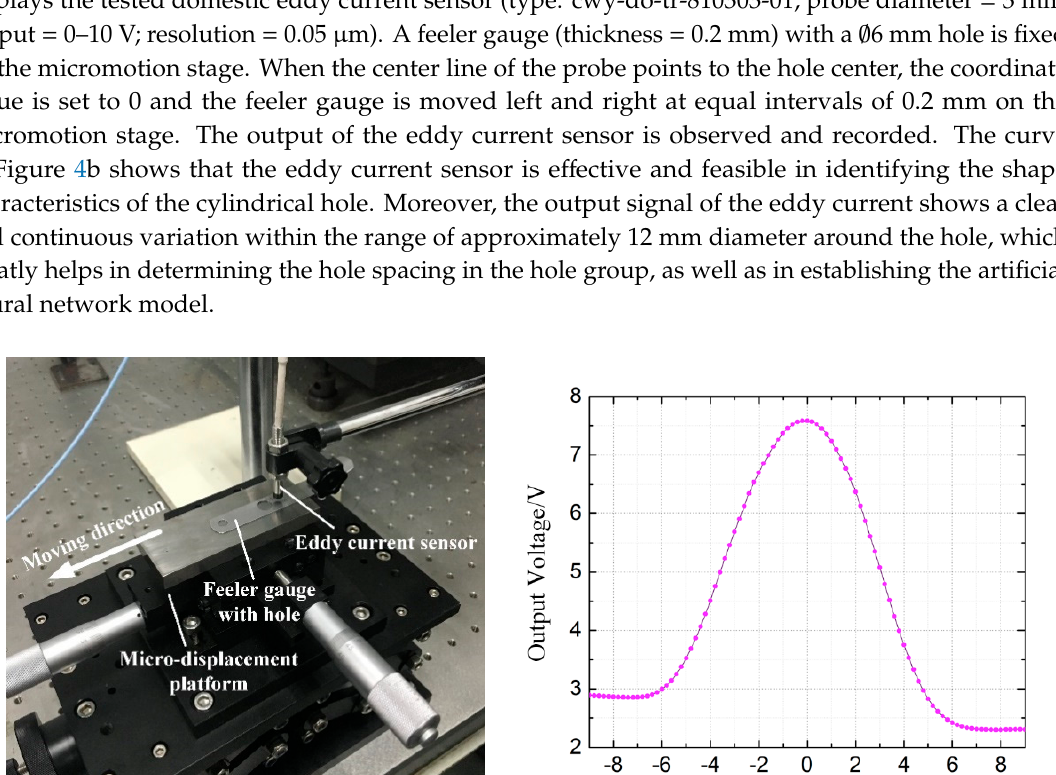
Figure 3. Selection of the features for the ball head; ( a ) hole shape; ( b ) groove shape.